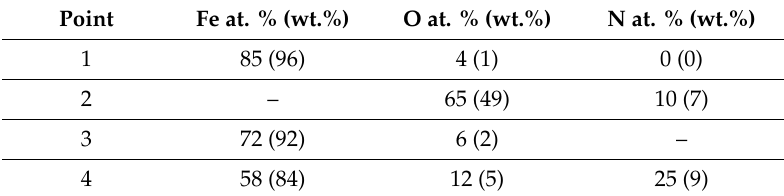
Table 7. EDS point analysis of sintered Fe with hexagonal boron nitride h-BN. Point Fe at. % (wt.%) O at. %